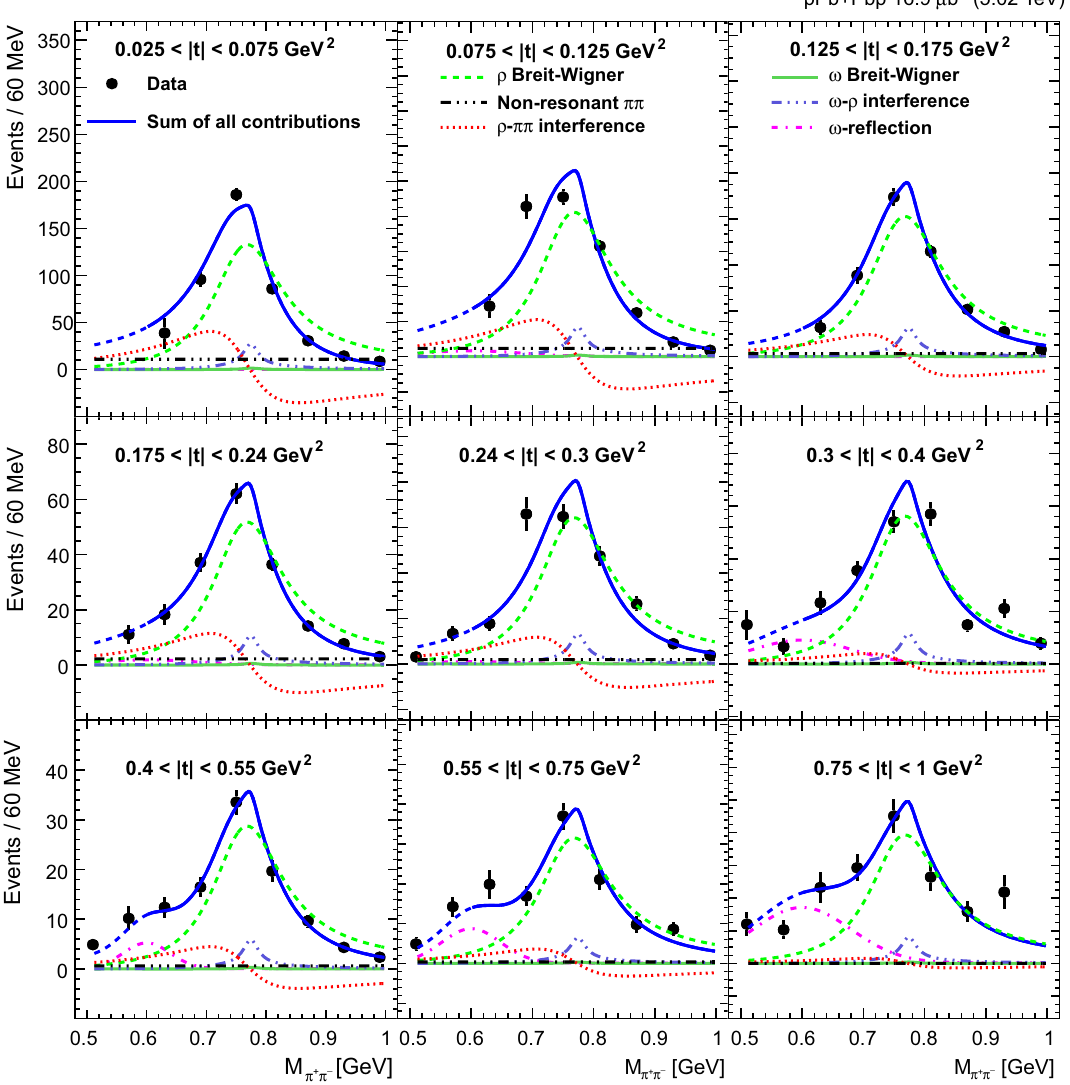
+ π − Fig. 4 Unfolded π invariant mass distributions in the pion pair rapidity interval | y + − | < 2 . 0 (full circles) fitted with the Söd- π π ing model in different | t | bins. The green dashed lines indicate res- onant ρ ( 770 ) 0 production, the red dotted lines the interference term, the magenta dash-dotted lines correspond to the background from